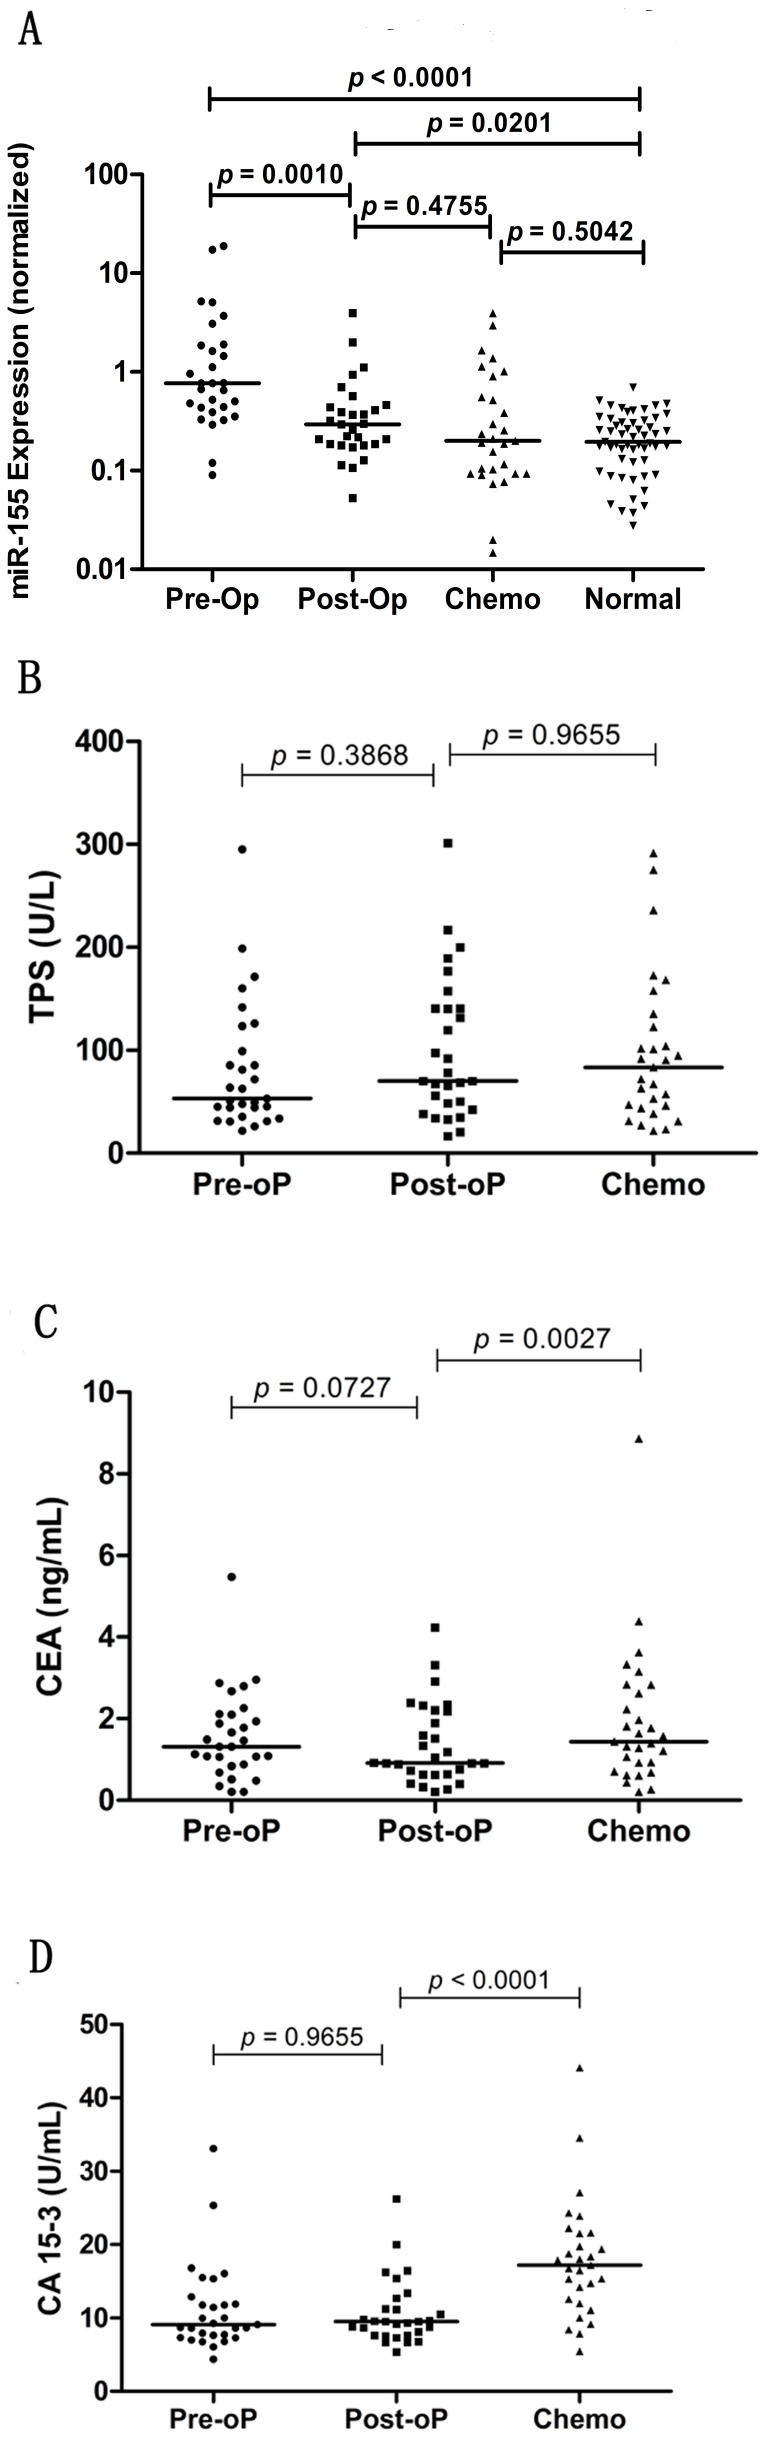
Changes in serum miR-155 and CA 15-3, CEA, TPS levels before (Pre-oP) and after surgery (Post-oP), and after chemotherapy (Chemo).Sera (n = 29) were collected from patients who underwent curative resection and adjuvant chemotherapy. The levels of miR-155 were significantly reduced after surgery (p = 0.0002), reaching levels comparable with healthy subjects (p = 0.5042) (A). The levels of TPS remained unchanged (p>0.05) (B). The levels of CA 15-3 and CEA underwent a significant elevation after chemotherapy (p = 0.0027 for CEA, p<0.0001 for CA 15-3) (C–D).